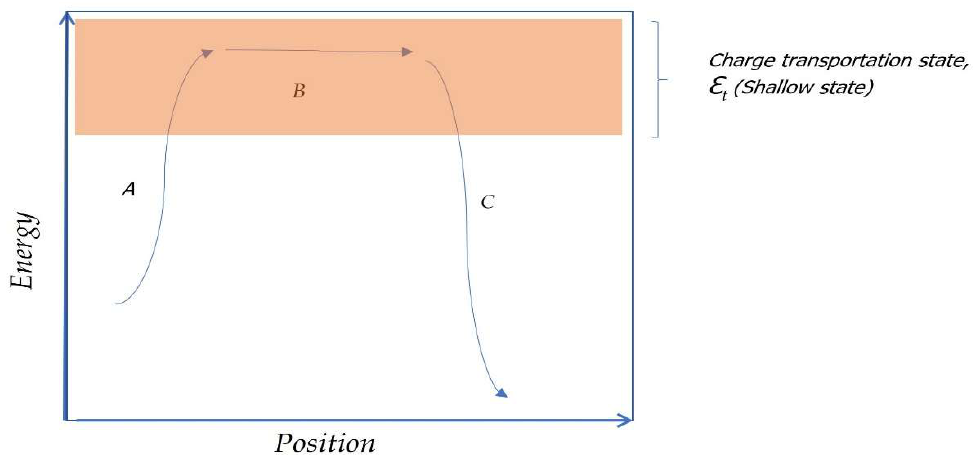
Figure 1. Charge carrier mechanisms: Hopping conduction processes for polymeric insulators.